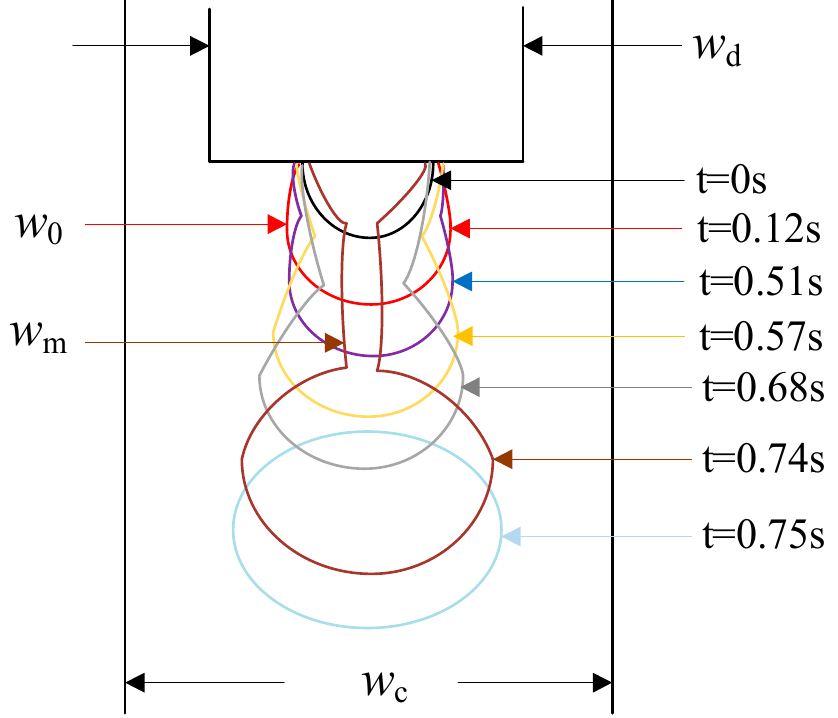
Figure 4. The schematic diagram of NaAlg micro-droplet in the breakup process. (1.5 wt%, Q d = 2 mL/h, Q c = 20 mL/h).